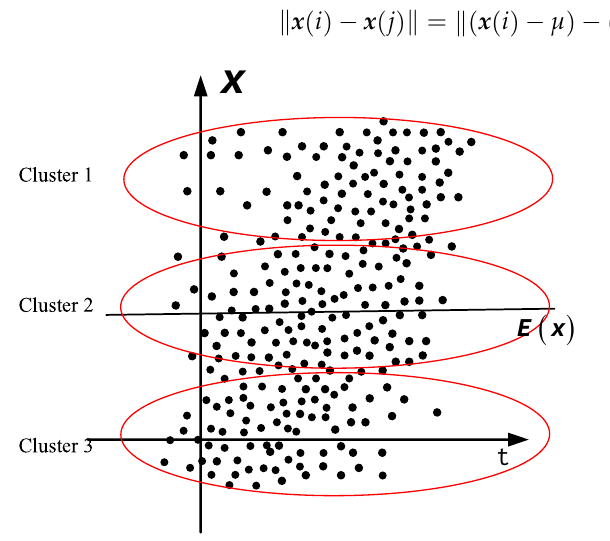
Figure 1. Cluster results for static process.